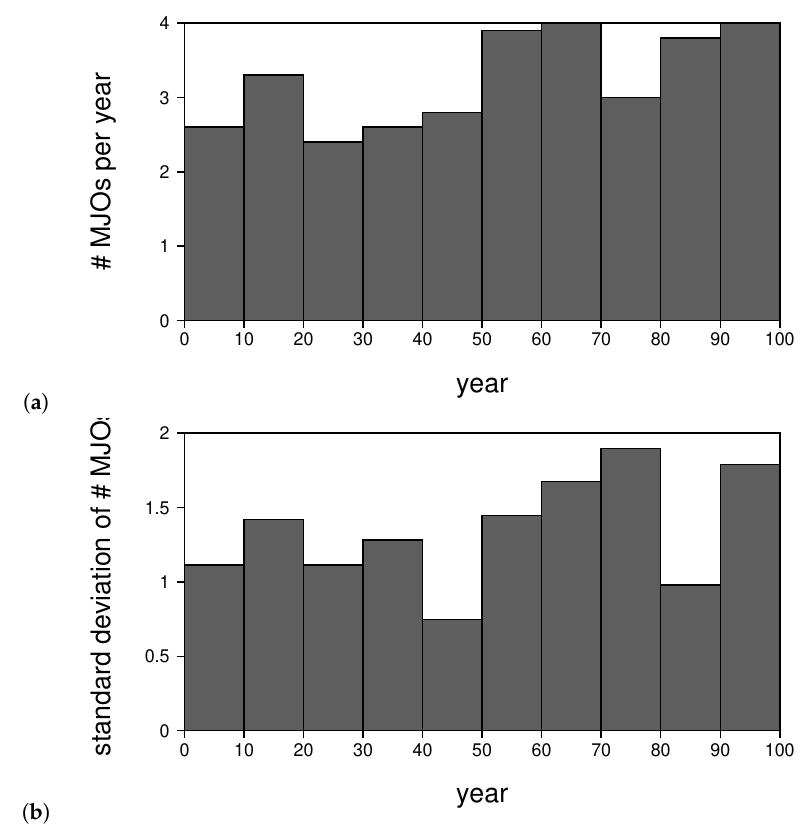
Figure 4. How the frequency of occurrence of MJOs and its deviation changes by decade over the course of the simulation. ( a ) Average frequency of occurrence (FOC) of MJOs for each decade. ( b ) Standard deviation of FOC for each